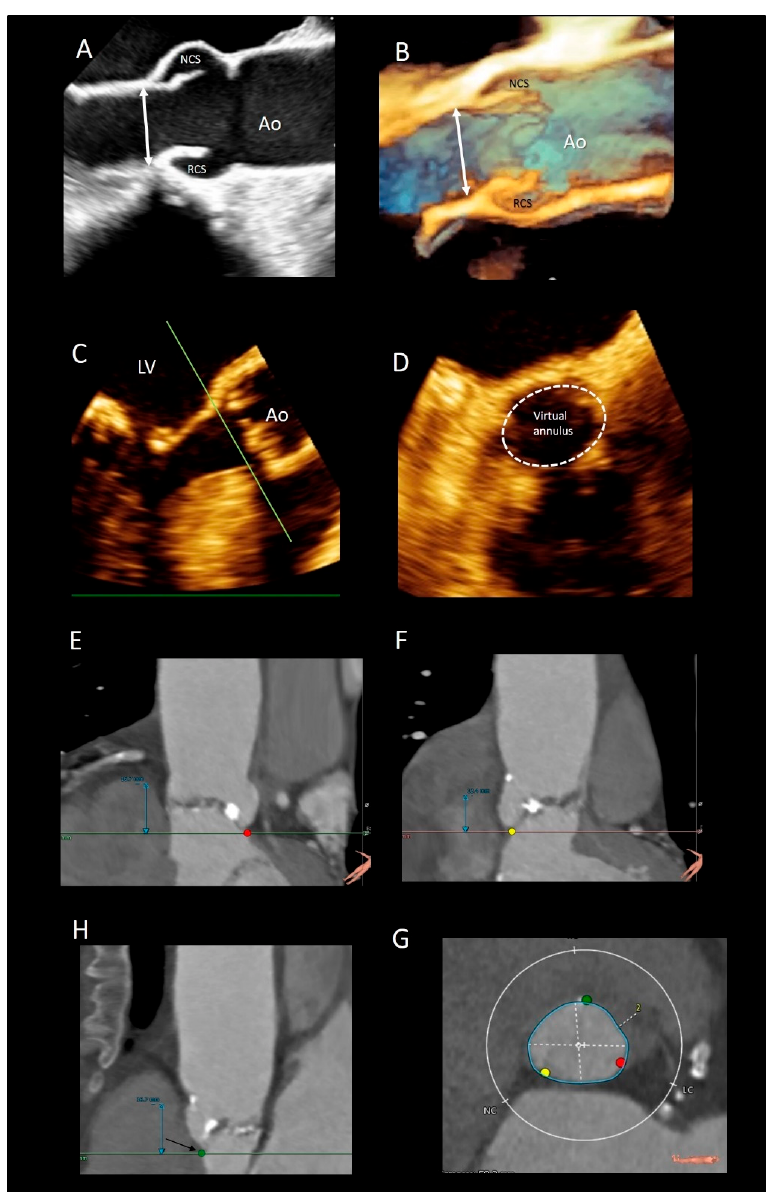
Figure 5. ( A ) The 2D and ( B ) 3D TEE long-axis view showing the echocardiographic annulus. ( C , D ) Multiplanar reconstruction using the 3D data set showing the virtual annulus. ( E , F , H ) CT scans showing the 3 nadirs (marked by the red, green, and yellow circles). ( G ) Dedicated software aligns the three nadirs in the same plane making possible measurements of diameters (white dotted lines) and circumference (blue line).